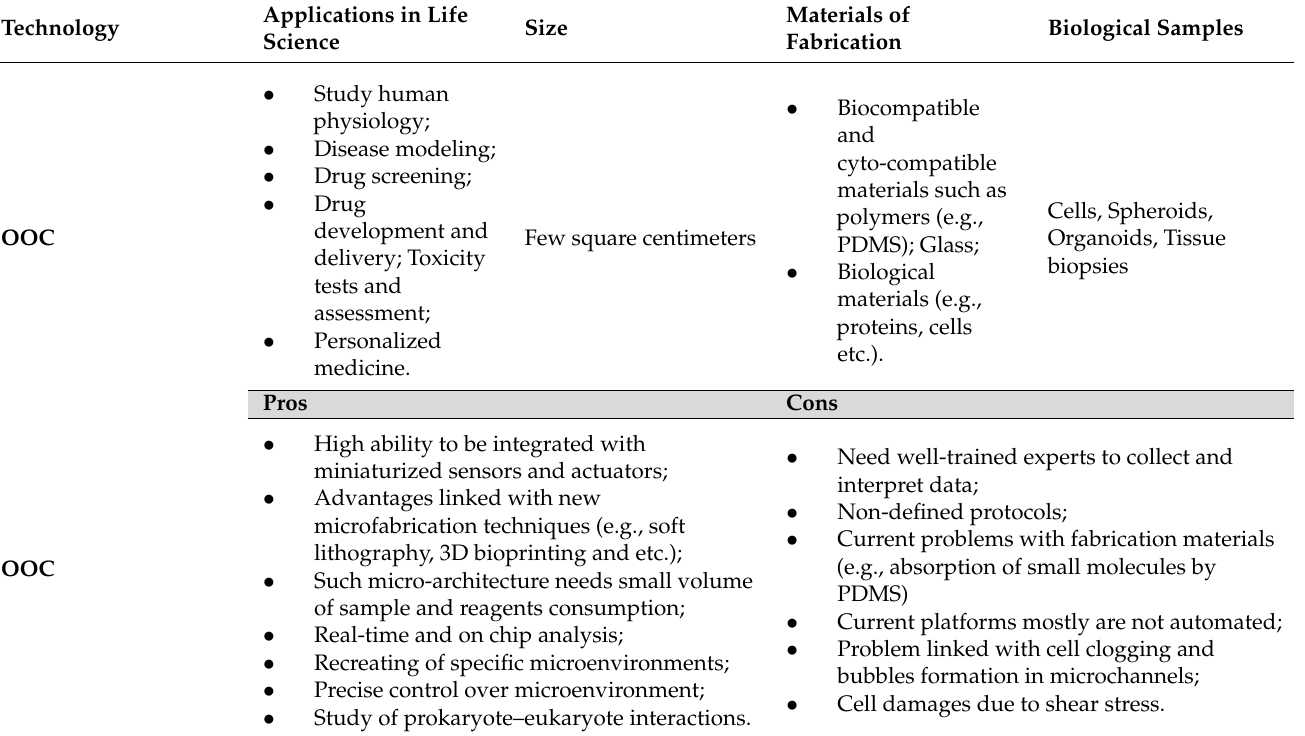
Table 5. Pros and cons of OOC